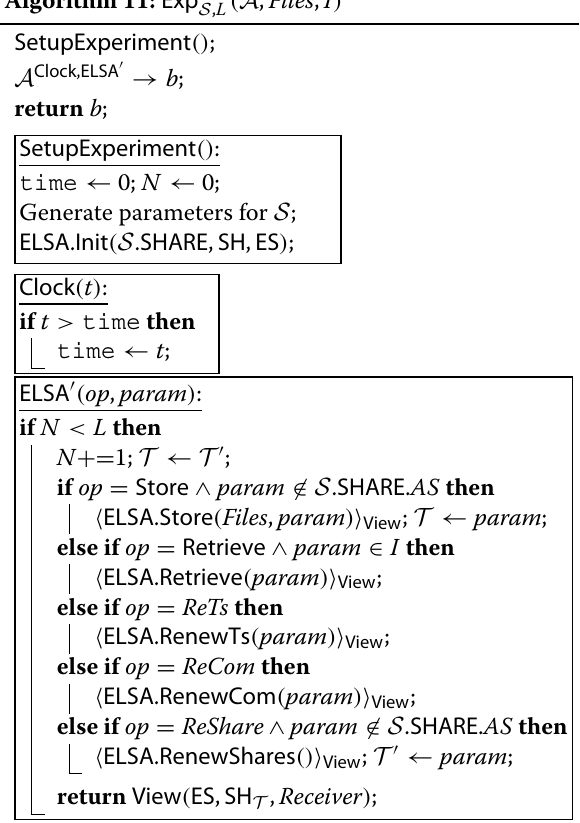
Algorithm 11: Exp Dist S